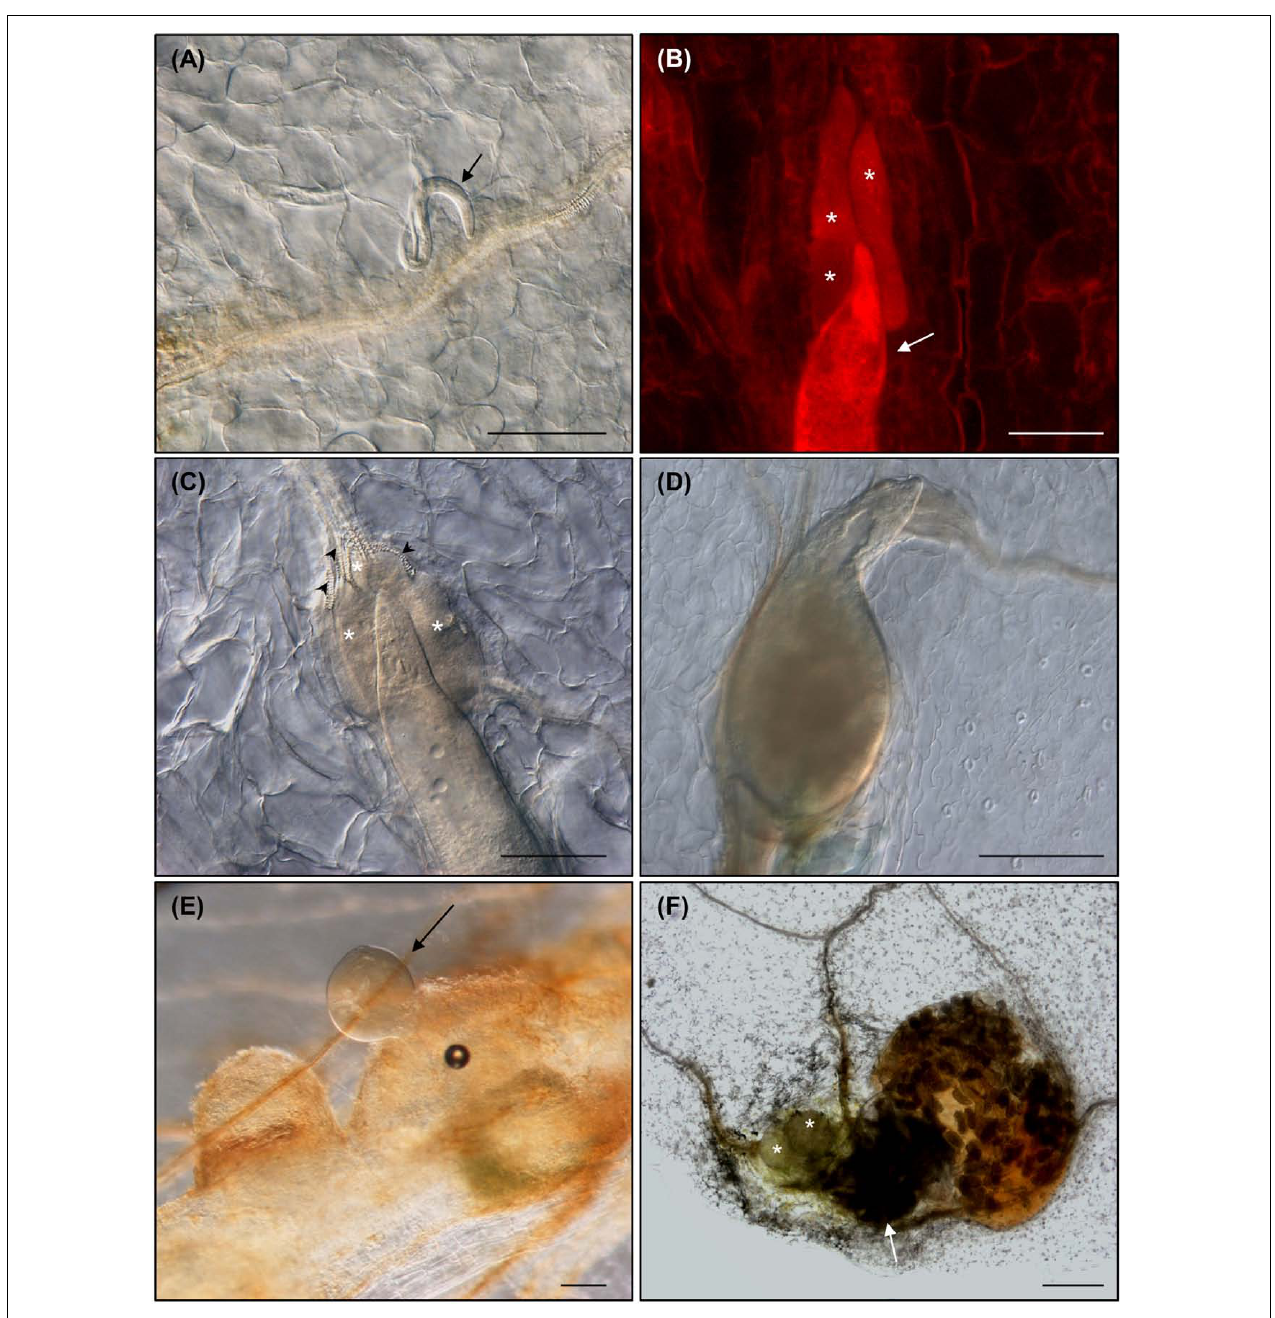
FIGURE 2 | Meloidogyne javanica root-knot nematodes (RKNs) are able to complete their life cycle in Arabidopsis thaliana leaves. (A) Nematode juvenile migrating through the parenchyma cells within a Col-0 leaf at 10 days after leaf culture and inoculation (daci), (B,C) established nematode feeding from clearly visible GCs at 18 and 24 daci, respectively (red fluorescence from propidium iodide staining), (D,E) developed females at 43 and 40 daci, respectively, and (F) life cycle was completed within excised leaves as shown by females with egg masses at 50 daci. Abundant xylem vessels around the GCs are also indicated with black arrow heads. Arrows and asterisks indicate the nematode and the GCs, respectively. N ≥ 45. Scale Bars: 100 µ m (A) and 200 µ m (B–F)